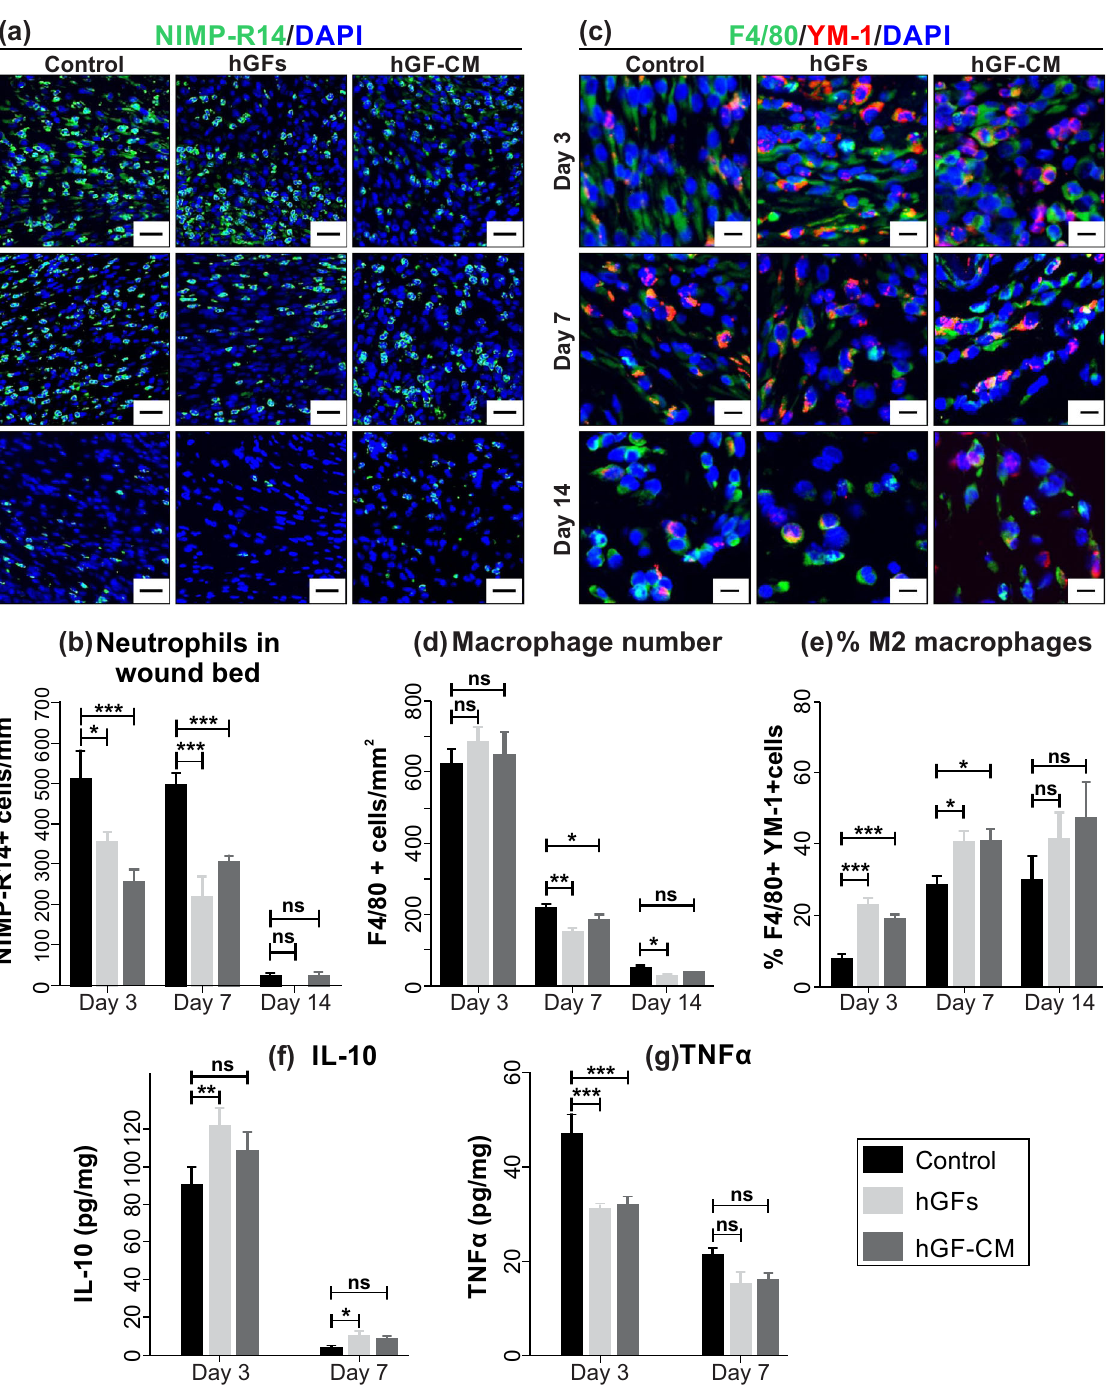
Fig. 3 The effect of hGFs and hGF-CM on in fl ammation. a , b Immuno fl uorescent detection and quanti fi cation of NIMP + neutrophils in hGF and hGF-CM treated wounds. Scale bars represent 0.2 mm. c , d Immuno fl uorescent detection and quanti fi cation of F4/80 + macrophages in hGFs and hGF-CM treated wounds. e Quanti fi cation of the ratio of F4/80 + and YM-1 + M2 macrophages in hGF and hGF-CM treated and control wounds. Images captured at ×20 objective. Scale bars represent 0.1 mm. Quanti fi cation of f IL-10 level (pg of IL-10 in 1 mg of total protein in wounds) and g TNF α level (pg of TNF α in 1 mg of total protein in wounds) in the wound tissues using ELISA. n = 8. All data is represented as mean ± SEM. * p < 0.05, ** p < 0.01, *** p < 0.001, ns = nonsigni fi